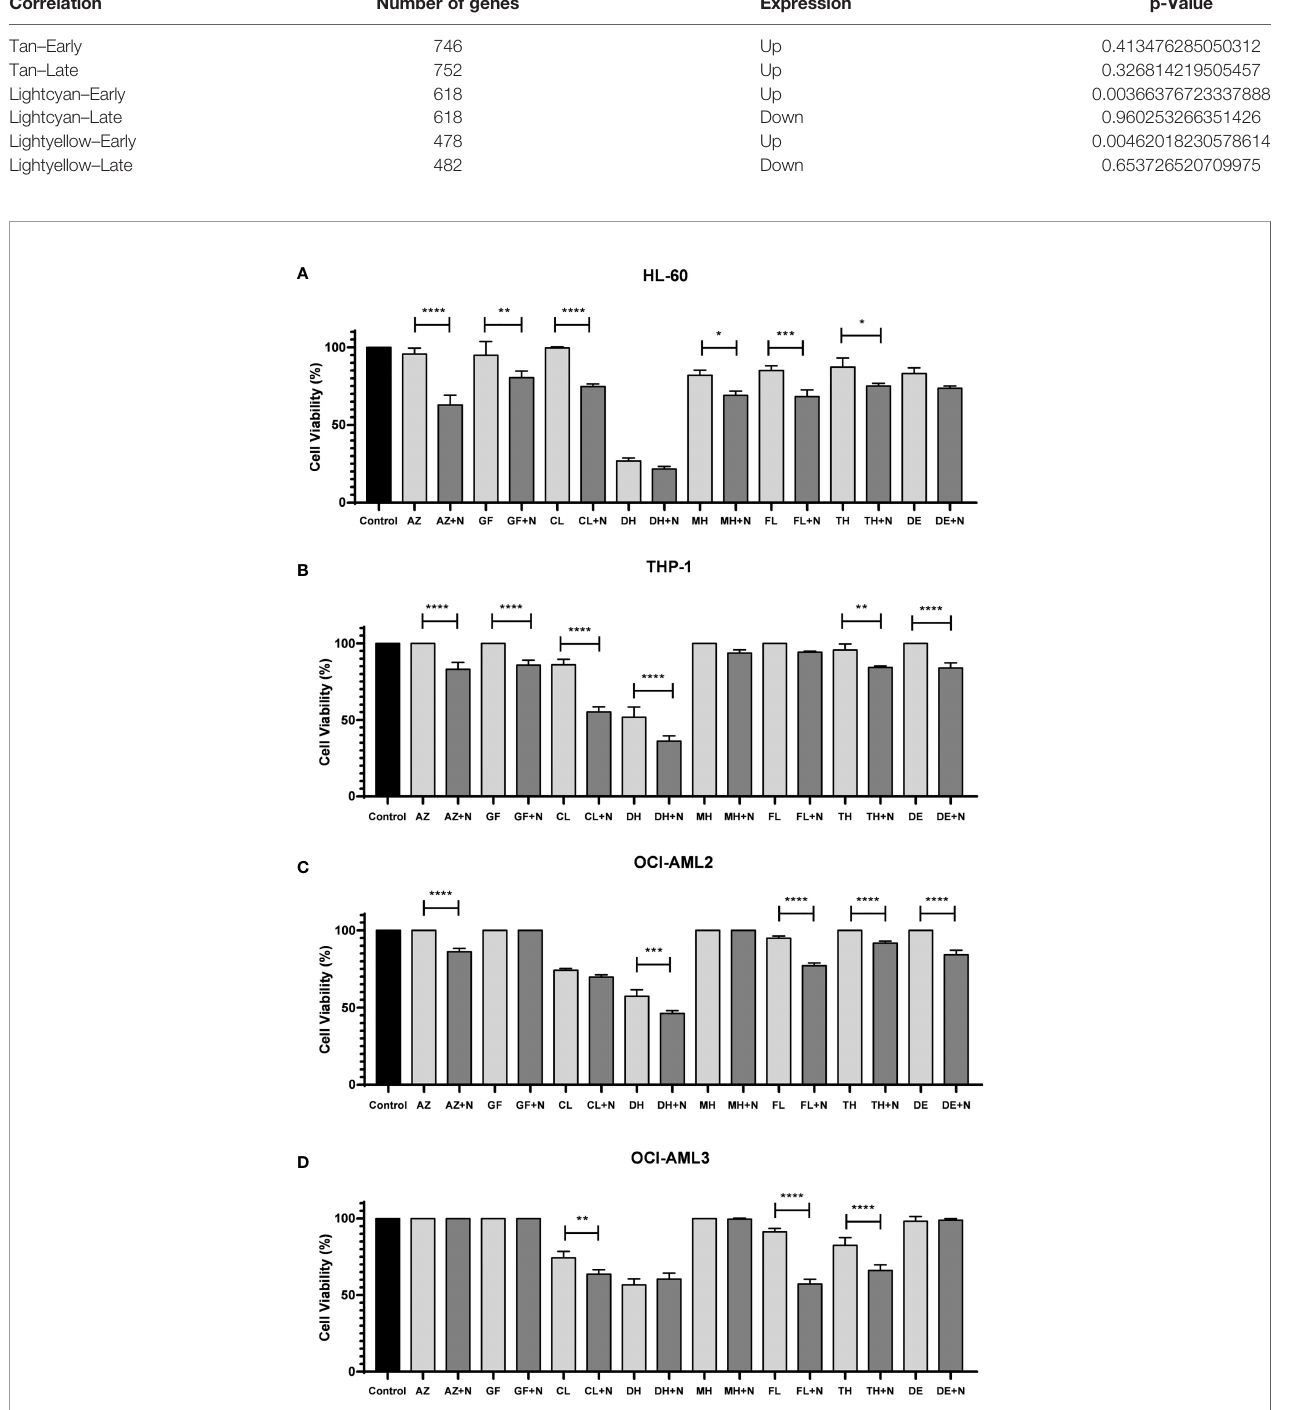
FIGURE 5 | Cell viability assay after treatment with selected FDA-approved anti-AML drugs combined with nimesulide. (A – D) Bar graph showing cell viability on cell lines (HL-60, THP-1, OCI-AML2, and OCI-AML3) after being treated and incubated for 24 h. Data shown are representative of an independent experiment in triplicate and presented as mean ± SD (n = 3). The p-value was determined using the one-way ANOVA comparing the drug alone and in combination with nimesulide, *p < 0.05; **p < 0.01; ***p < 0.001; ****p < 0.0001. Control: DMSO. N, nimesulide; AZ, azacitidine; GF, gilteritinib fumarate; CL, cladribine; DH, doxorubicin hydrochloride; MH, mitoxantrone hydrochloride; FL, fl udarabine; TH, thioguanine; DE, decitabine; FDA, Food and Drug Administration; AML, acute myeloid leukemia; DMSO, dimethyl